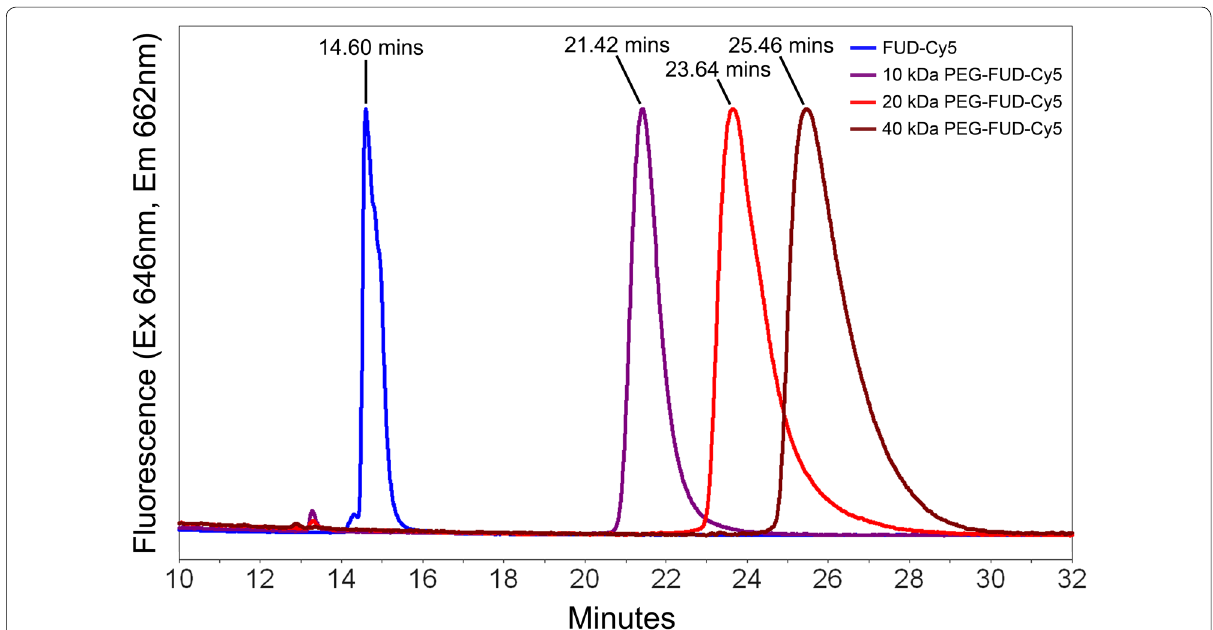
Fig. 4 Overlay of reversed phase high performance liquid chromatography (RP-HPLC) chromatograms showing fluorescence activity and preservation of relative retention times of sulfo-Cy5 labeled FUD and its sulfo-Cy5 labeled 10–40 kDa PEG conjugates. The analysis was made using a C8 column and an elution gradient composed of H 2 O 0.1% FA in the A side and acetonitrile 0.1% FA in the B + +